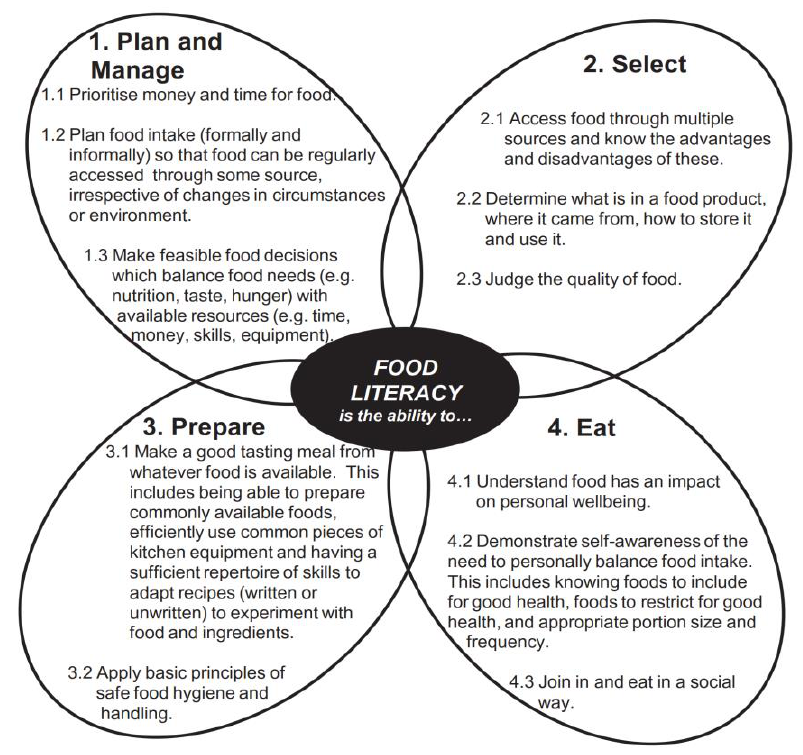
Figure 1. Food Literacy pillars and components (Source: Vidgen and Gallegos, 2014).